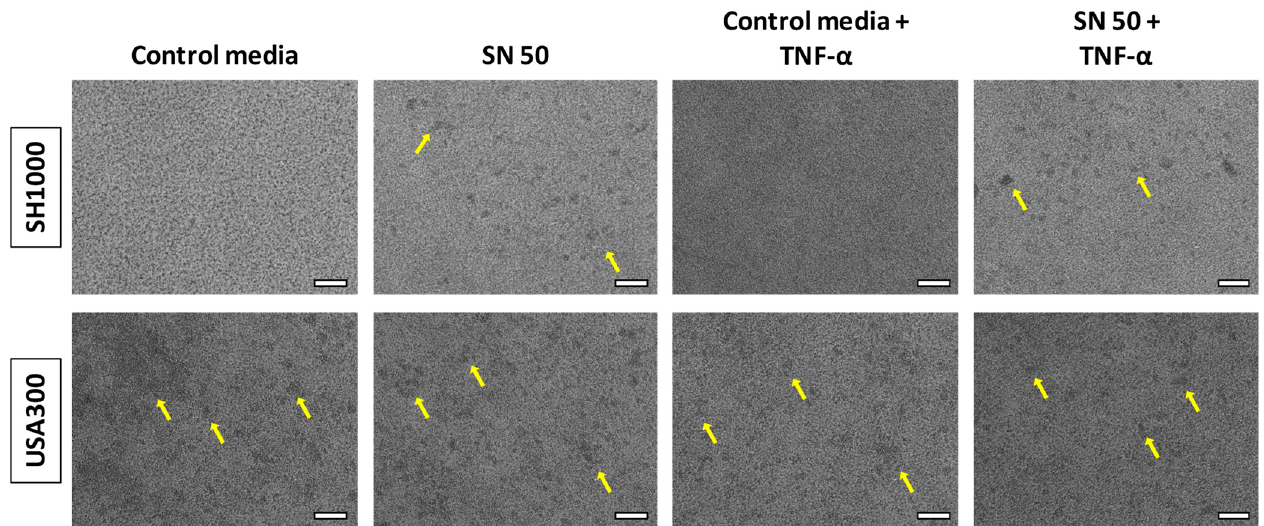
Figure 2. Impact of Saos-2 culture supernatant on S. aureus biofilm organization. Yellow arrows indicate aggregates. Control media (50% [DMEM + 10% FBS] and 50% MM), SN 50 (50% Saos-2 culture supernatant and 50% MM), Control media + TNF- α (50% [DMEM + 10% FBS + 20 ng/mL TNF- α ] and 50% MM), or SN 50 + TNF- α (50% [Saos-2 challenged with TNF- α culture supernatant + 20 ng/mL] and 50% MM). One representative image of each technical duplicate was acquired for each condition of each batch (for one biological replicate). The scale bars indicate 50 µ